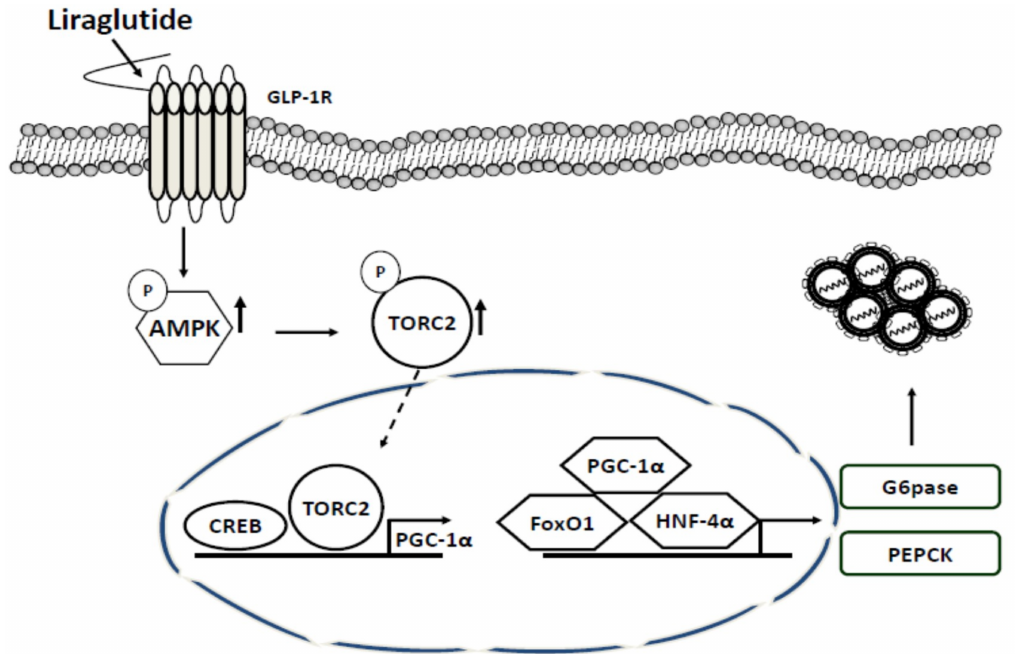
Figure 5. Antiviral action of liraglutide in HCV replication. Liraglutide actuated GLP-1 response to enhance AMPK phosphorylation which phosphorylated TORC2 to depletion nuclear TORC2 to inhibit the transactivation of gluconeogenic genes leading to the suppression of HCV